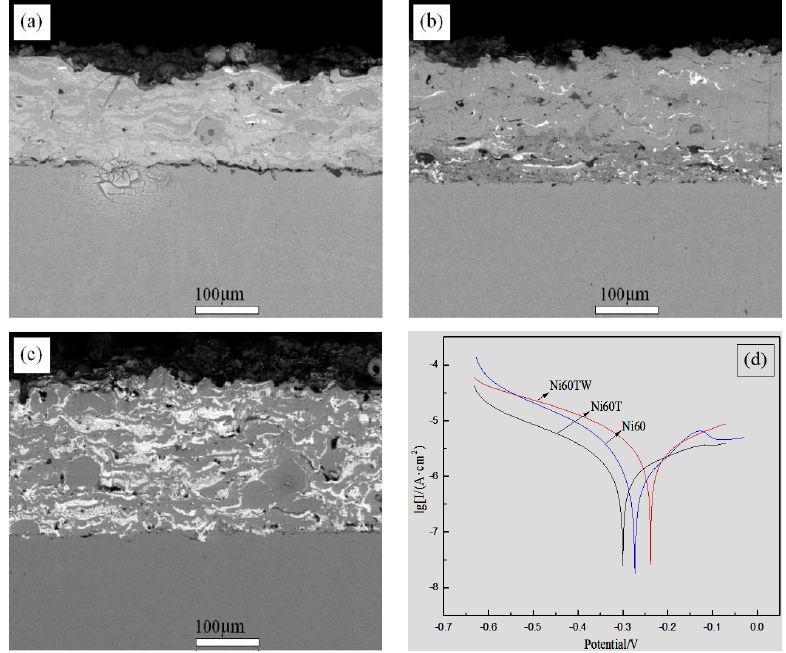
Figure 6. Corrosion performance of composite ceramic coatings: ( a ) Ni60; ( b ) Ni60T; ( c ) Ni60TW; ( d ) Eelectrochemical corrosion curve of the three coatings.